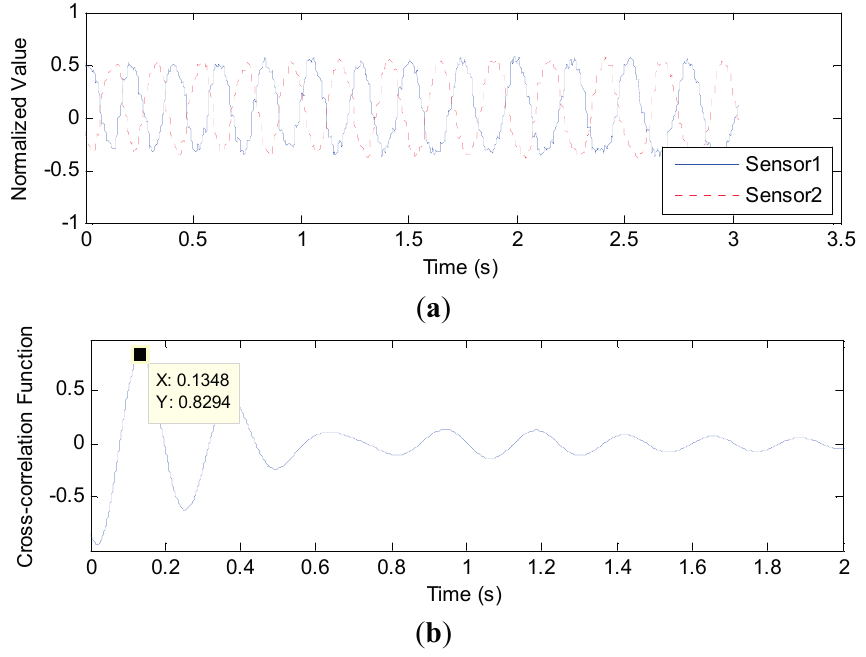
Figure 9. Signal waveforms and the resulting correlation function in 2.65 mm inner diameter pipe with 4.0 mL/min gas flowrate and 4.0 mL/min liquid flowrate: ( a ) Normalized signals from the two capacitance sensors; ( b ) Cross-correlation function between the two signals in